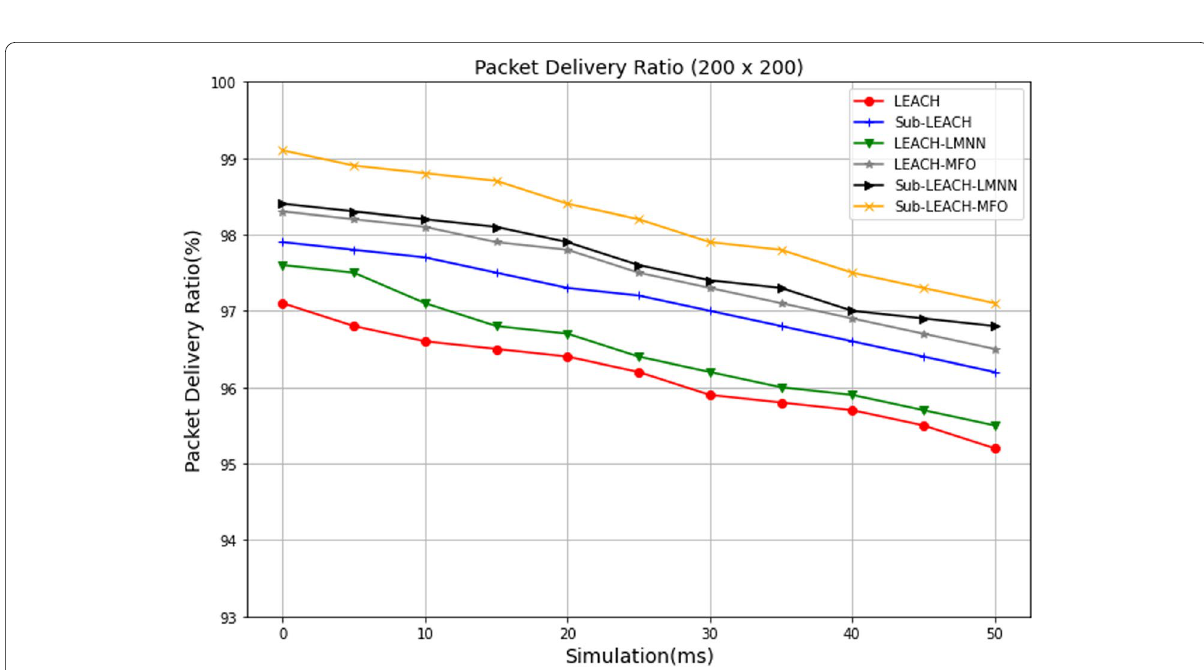
Fig. 13 Graphical representation of PDR for 100m